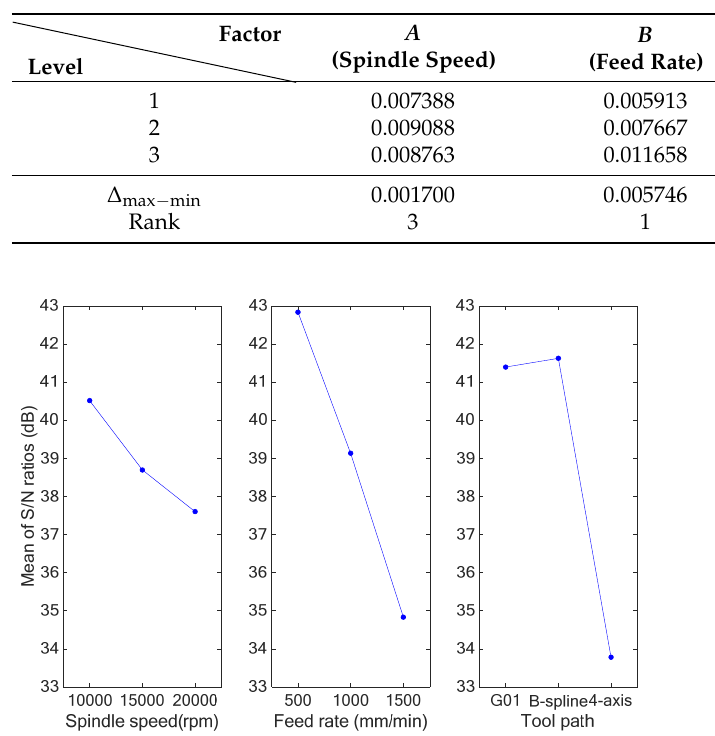
Figure 18. Graph of S/N ratios for profile errors.